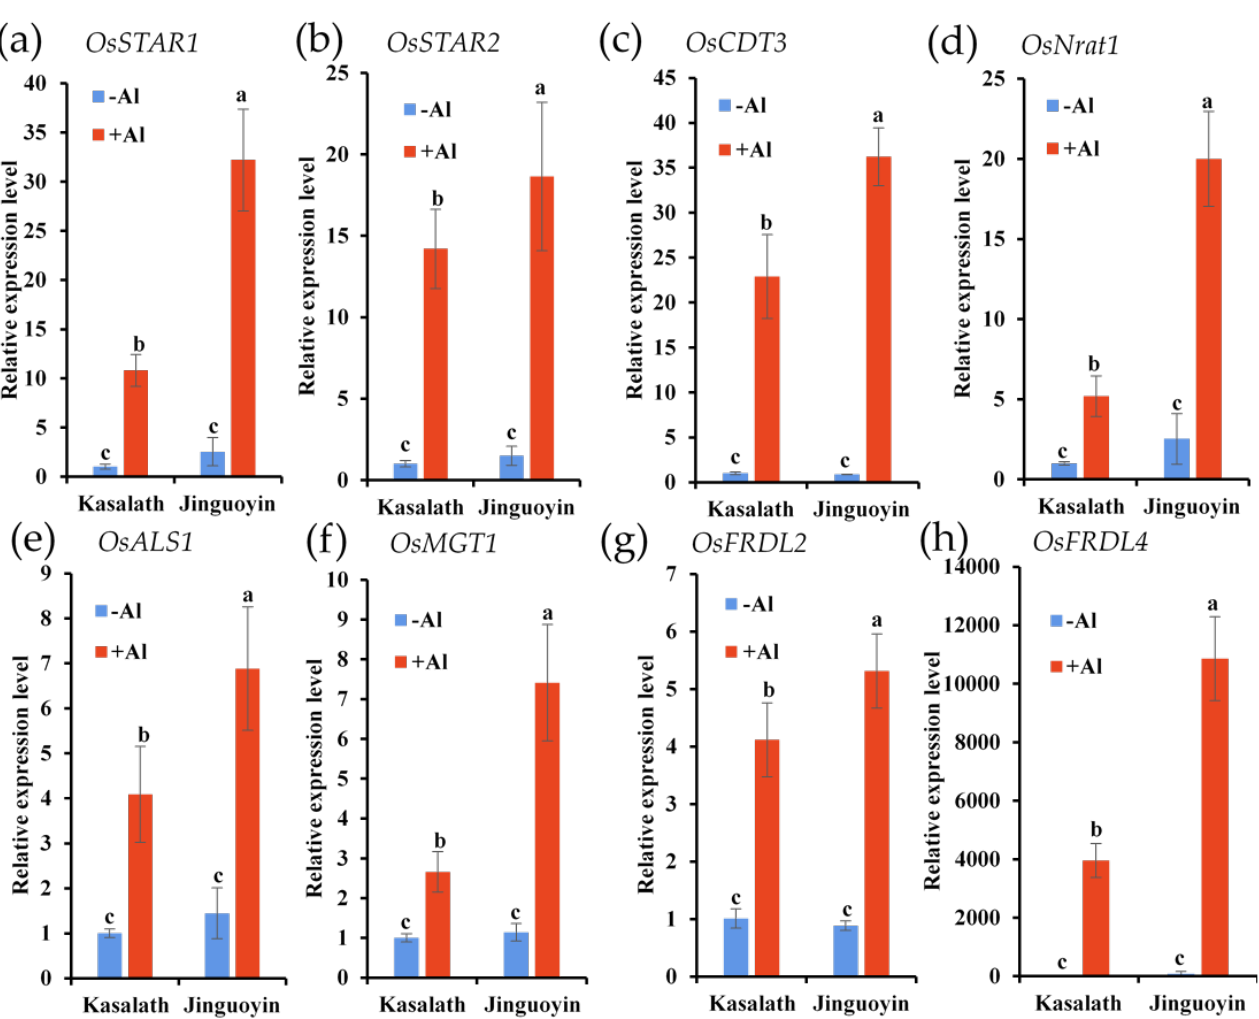
Figure 7. Gene expression pattern analysis of ART1-regulated genes in two indica rice cultivars. The expression level of OsSTAR1 ( a ), OsSTAR2 ( b ), OsCDT3 ( c ), OsNrat1 ( d ), OsALS1 ( e ), OsMGT1 ( f ), OsFRDL2 ( g ), and OsFRDL4 ( h ) was determined by quantitative RT-PCR. Histone H3 was used as an internal standard. Expression level relative to Kasalath root ( − Al) is shown. Seedlings of Kasalath and Jinguoyin were exposed to a 0.5 mM CaCl 2 (pH 4.5) solution containing 0 or 50 µ M Al for 24 h. Data are mean ± SD (n = 3). Different letters indicate significant differences at a p -value <0.05 by Tukey’s test.